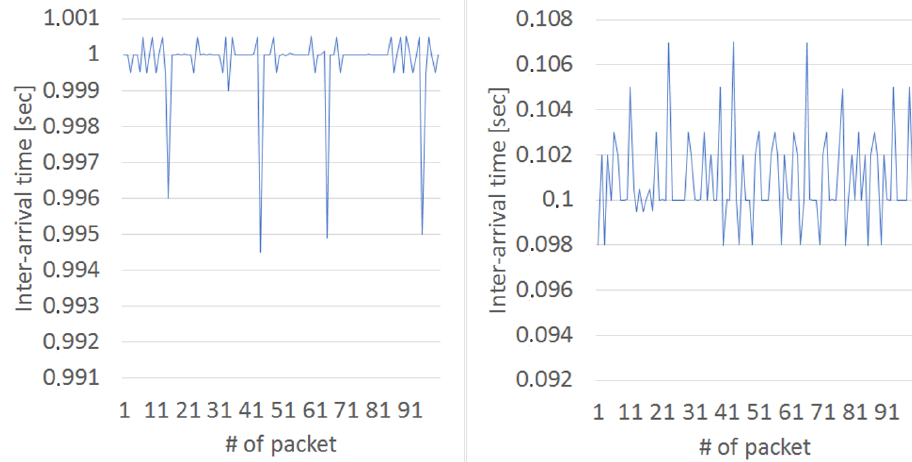
Figure 21. Jitter results ( left ): 1000 Byte packets, 1000 ms sending period, ( right ): 1000 Byte packets, 100 ms sending period.